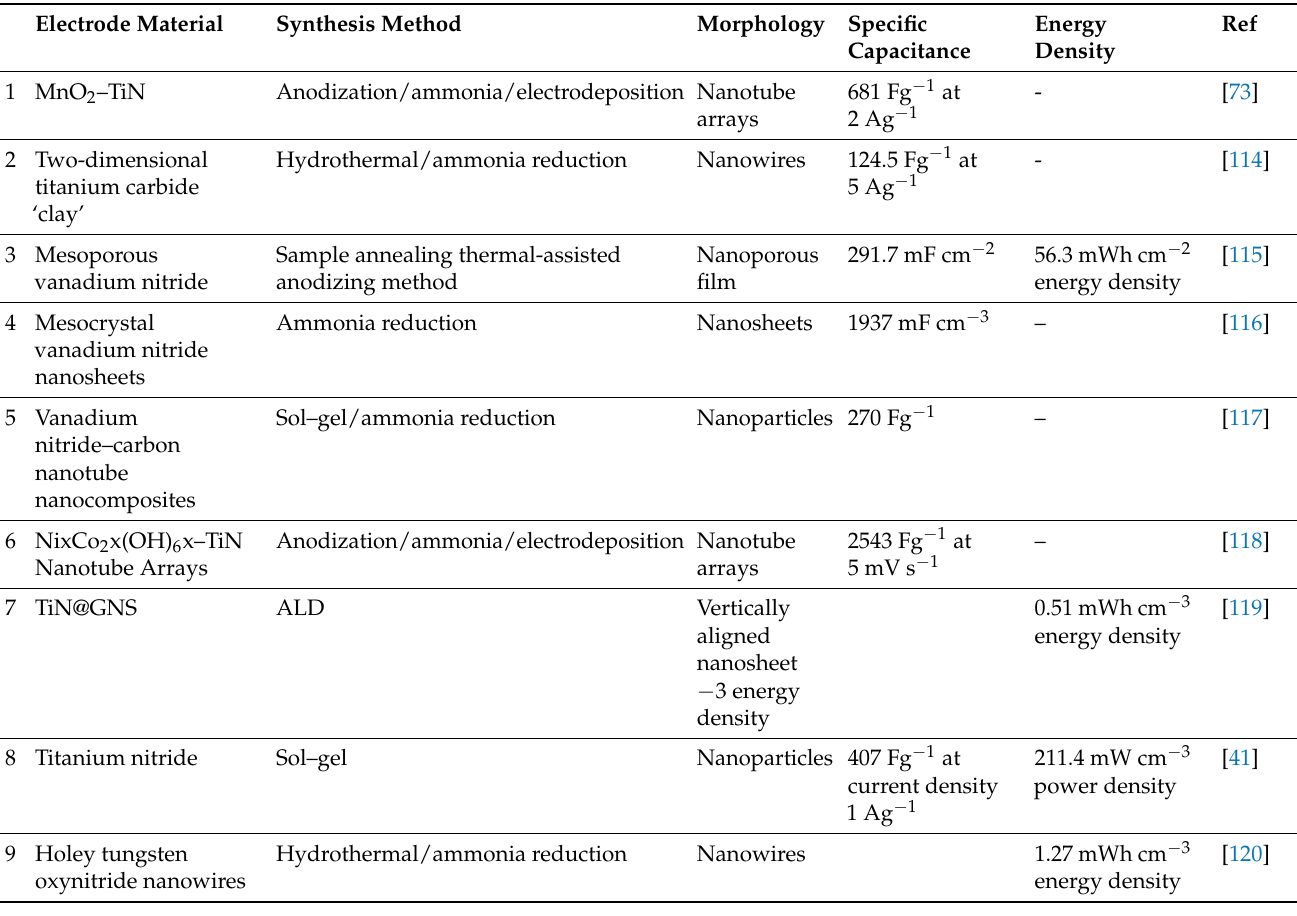
Table 1. Synthesis methodology, morphology and electrochemical parameters of a few metal